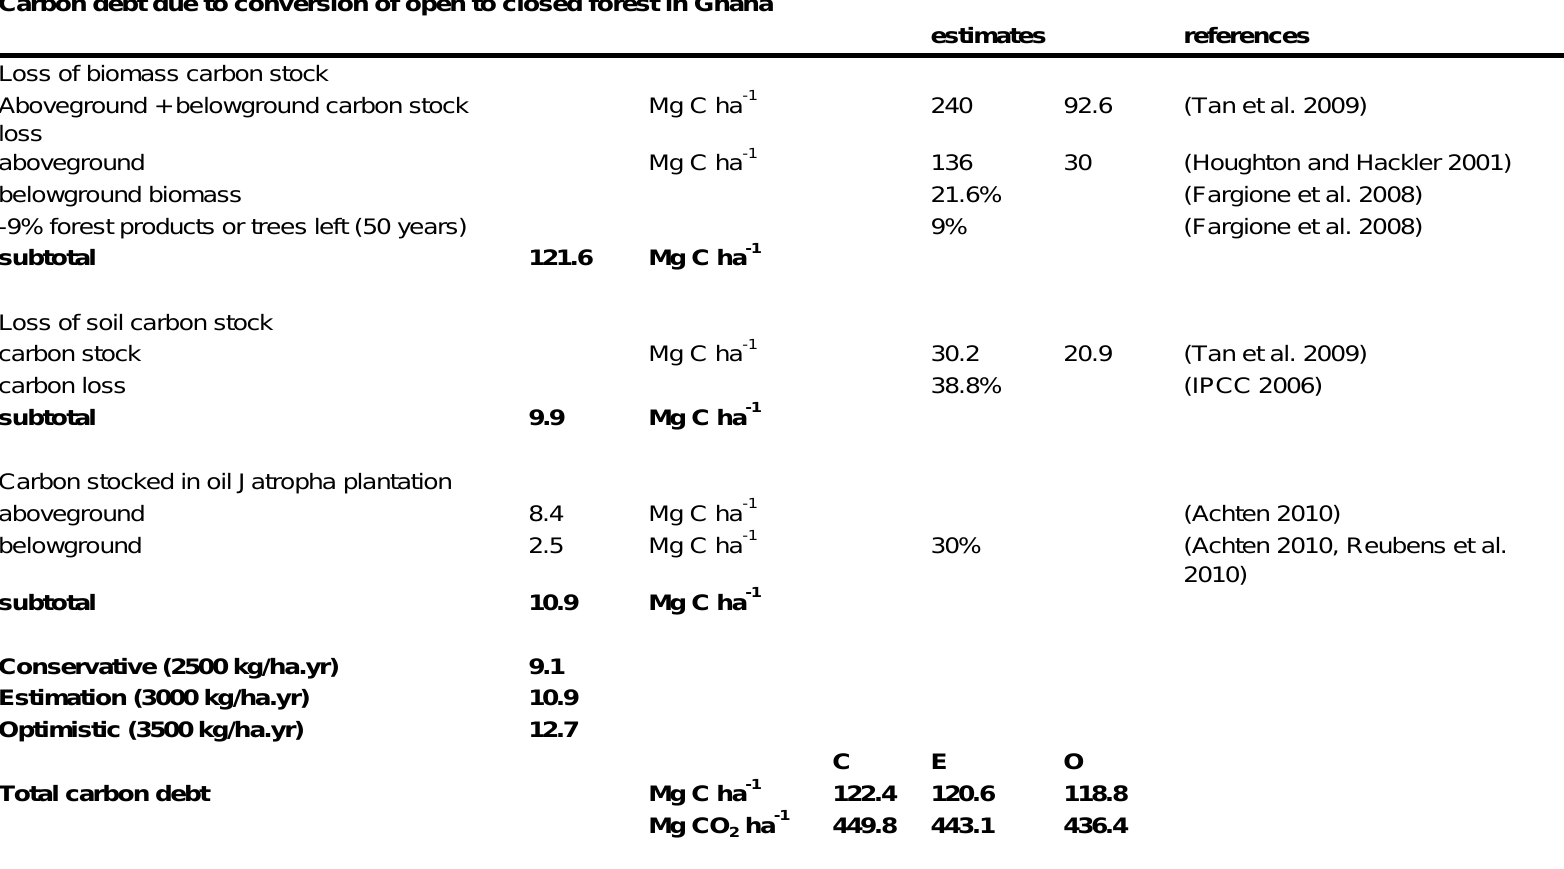
Table A3.1. Carbon debt calculation of Ghana